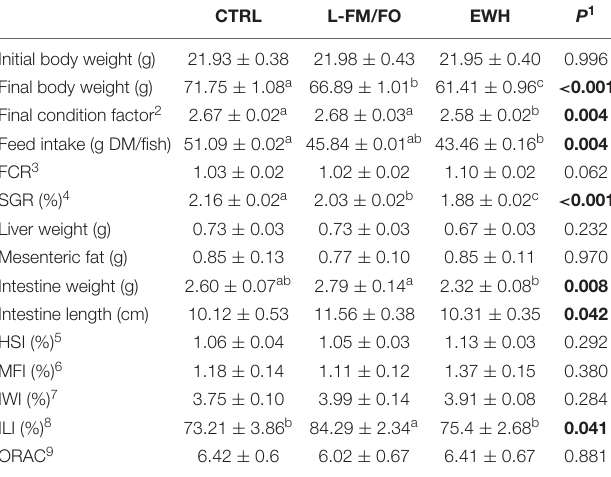
TABLE 2 | Effects of dietary treatment on growth performance and antioxidant capacity of gilthead sea bream juveniles fed to visual satiety from May to July (8 weeks) with control (CTRL), low fish meal/fish oil (L-FM/FO) diet, and EWH diets.